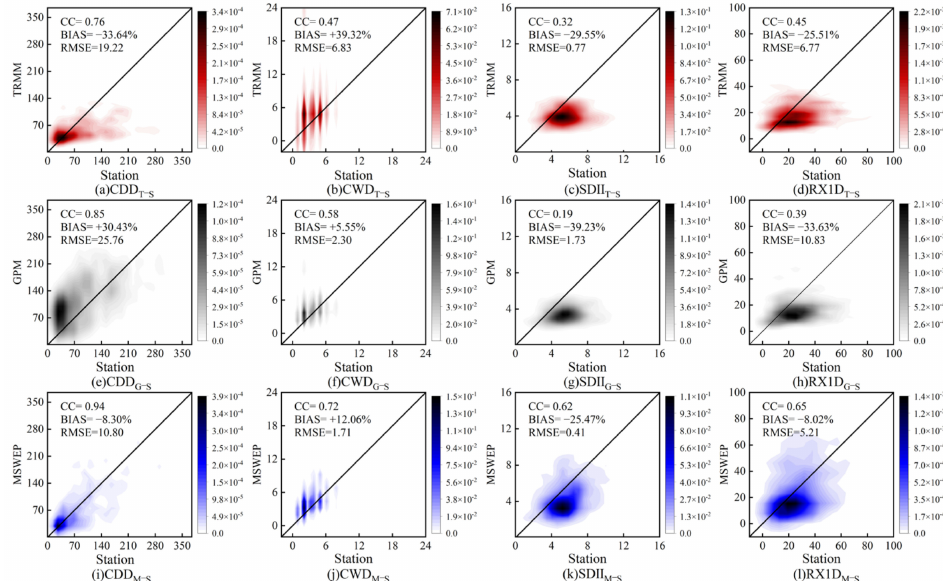
Figure 7. Density scatter of four extreme precipitation indices CDD ( a , e , i ), CWD ( b , f , j ), SDII ( c , g , k ) and RX1D ( d , h , l ) for precipitation products. TRMM ( a – d ); GPM ( e – h ); MSWEP ( i – l